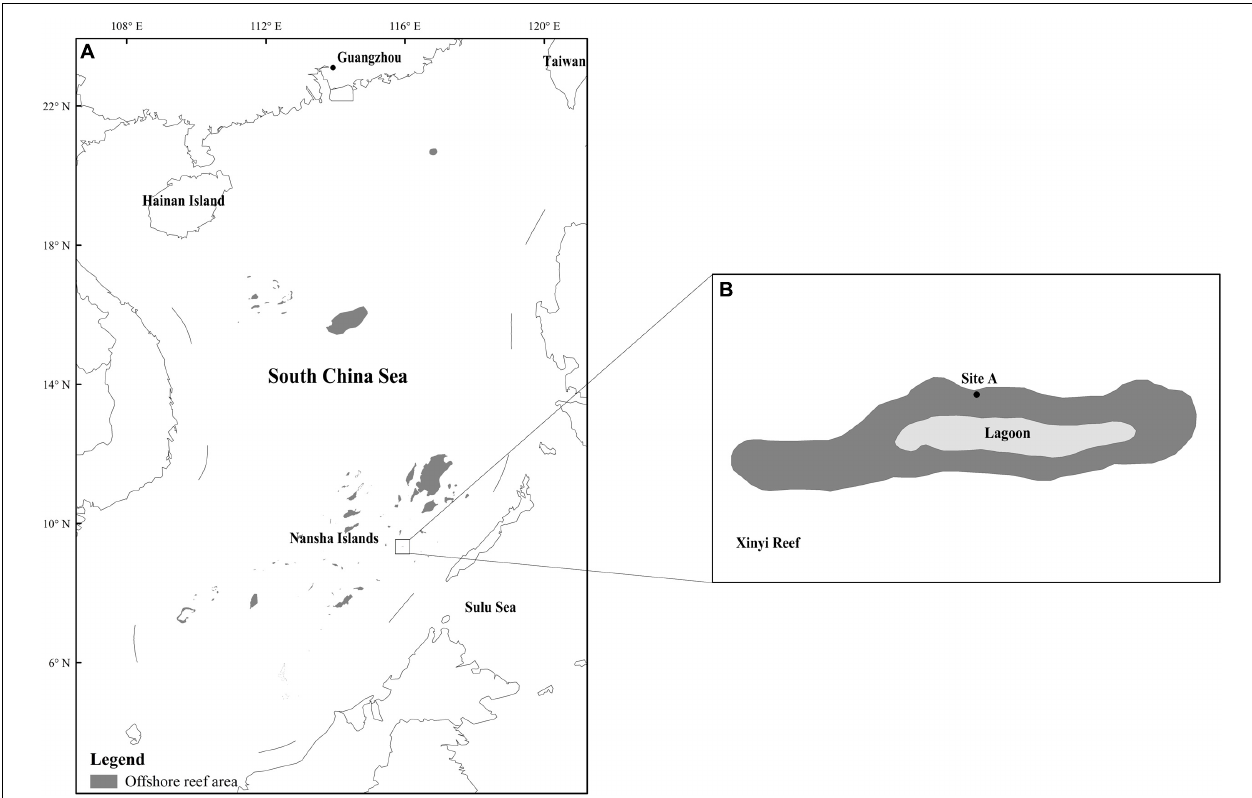
FIGURE 1 | Location map of sampling site A at Xinyi Reef, South China Sea. (A) Map of the whole South China Sea with labeled coral reef area. The Xinyi Reef is marked by a box. (B) The Xinyi Reef is magnified showing sampling site A (9 ◦ 20 (cid:48) 6 (cid:48)(cid:48) N, 115 ◦ 55 (cid:48) 49 (cid:48)(cid:48) E). The map was constructed using software ArcGIS (ver. 10.1). The offshore reef area was drawn using remote sensing images (fused by landsat 8 multispectral bands and panchromatic band) with resolution of 15